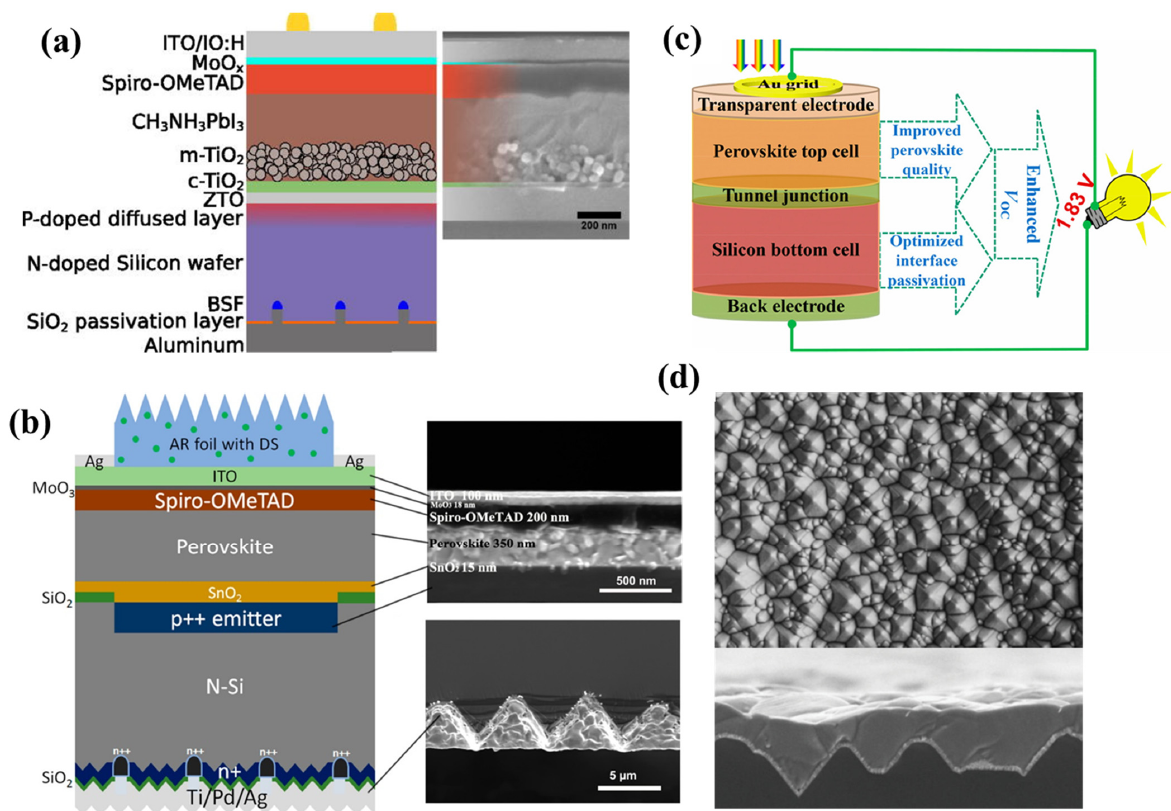
Figure 20. ( a ) Structure of the monolithic tandem cell with ZTO layer. Reprinted with permission from ref. [102]. Copyright 2016 AIP Publishing; ( b ) schematic of the perovskite/silicon solar cell and cross-sectional SEM image. Reprinted with per- mission from ref. [104]. Copyright 2019 American Chemical Society; ( c ) schematic of the device architecture of the perov- skite/heterojunction solar cells. Reprinted with permission from ref. [105]. Copyright 2019 American Chemical Society; ( d ) top-view image of the textured c-Si surface and cross-section of the perovskite crystal layer. Reprinted with permission from ref. [109]. Copyright 2020 The American Association for the Advancement of Science.